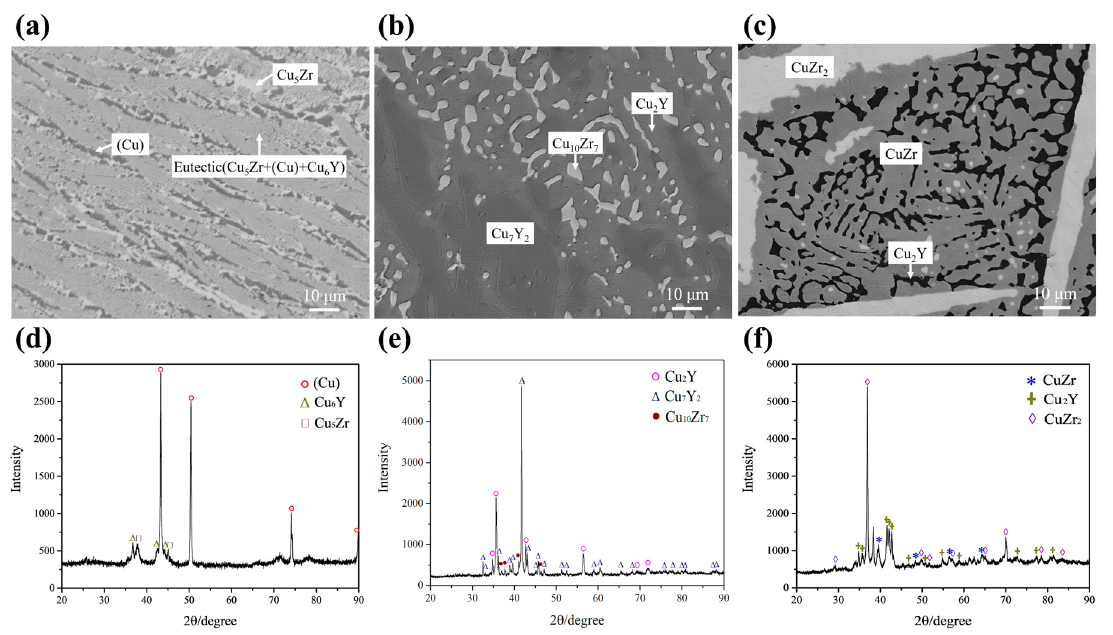
Figure 6. BSE micrographs and XRD patterns of annealed alloys: ( a , d ) A1 Cu 90 Zr 8 Y 2 (at.%); ( b , e ) A3 Cu 69 Zr 10 Y 21 (at.%); ( c , f ) A8 Cu 48 Zr 41 Y 11 (at.%).